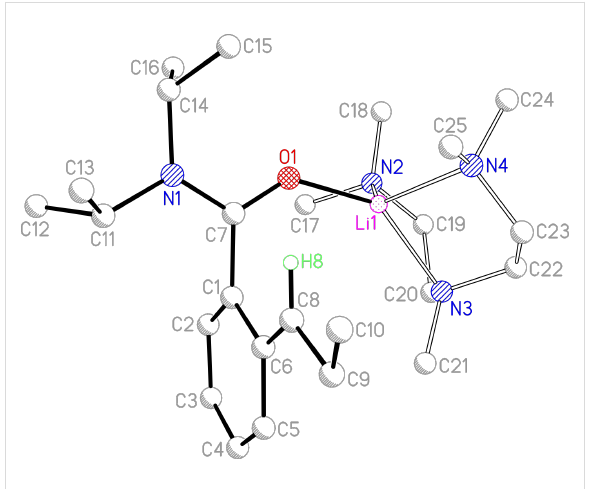
Figure 1: Molecular structure of 6 -Li l ·PMDTA; H-atoms (excl. H8) omitted for clarity. Selected bond lengths (Å) and angles (°):